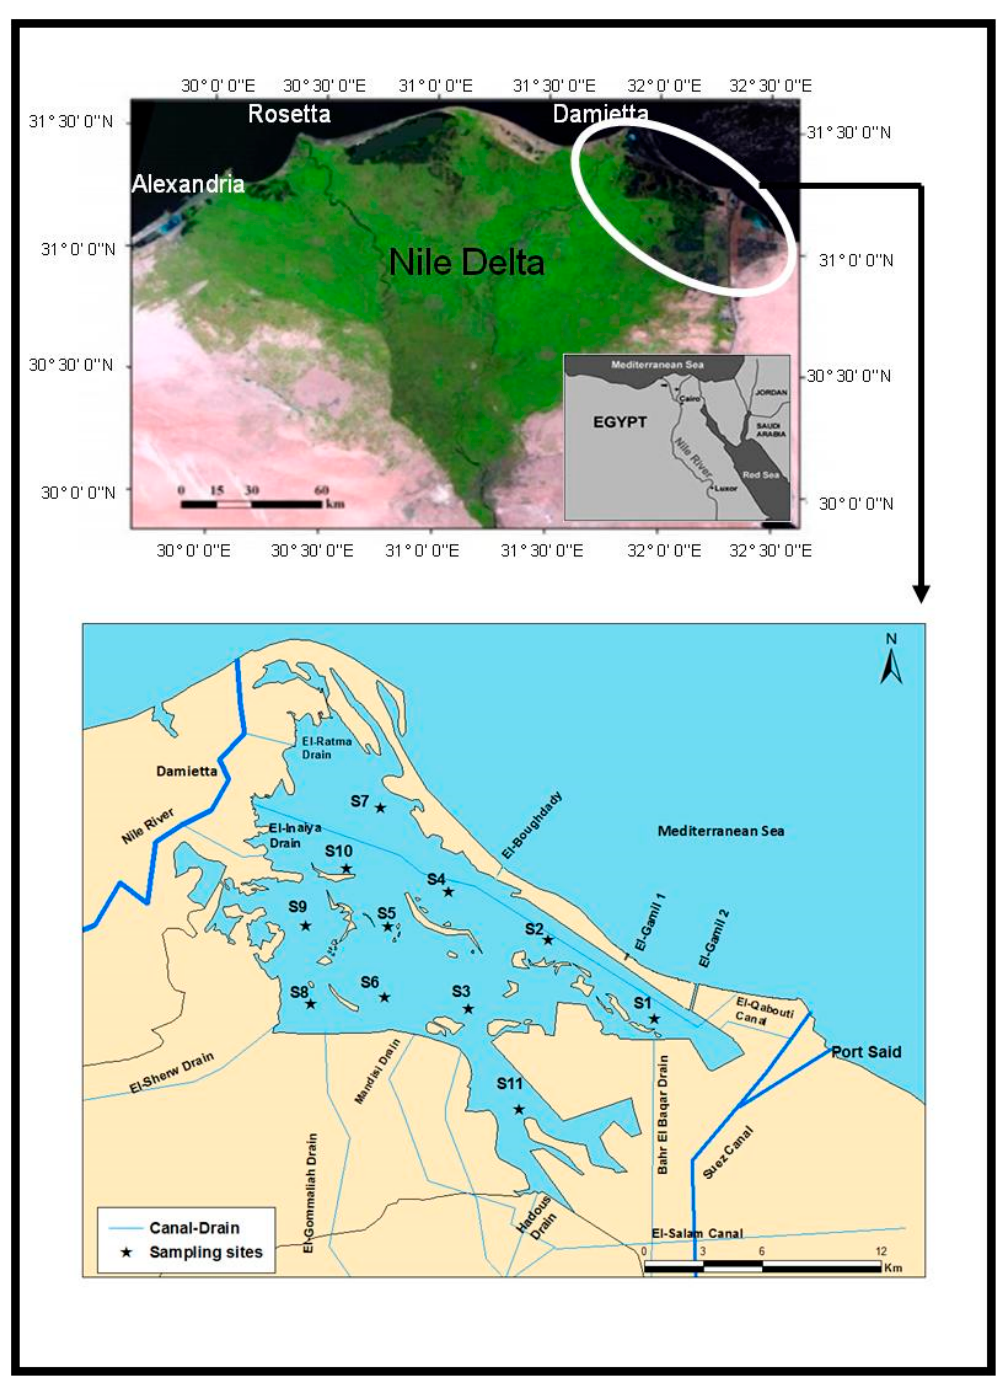
Figure 1. Location of the study area (Lake Manzalah) and of the sampling stations.